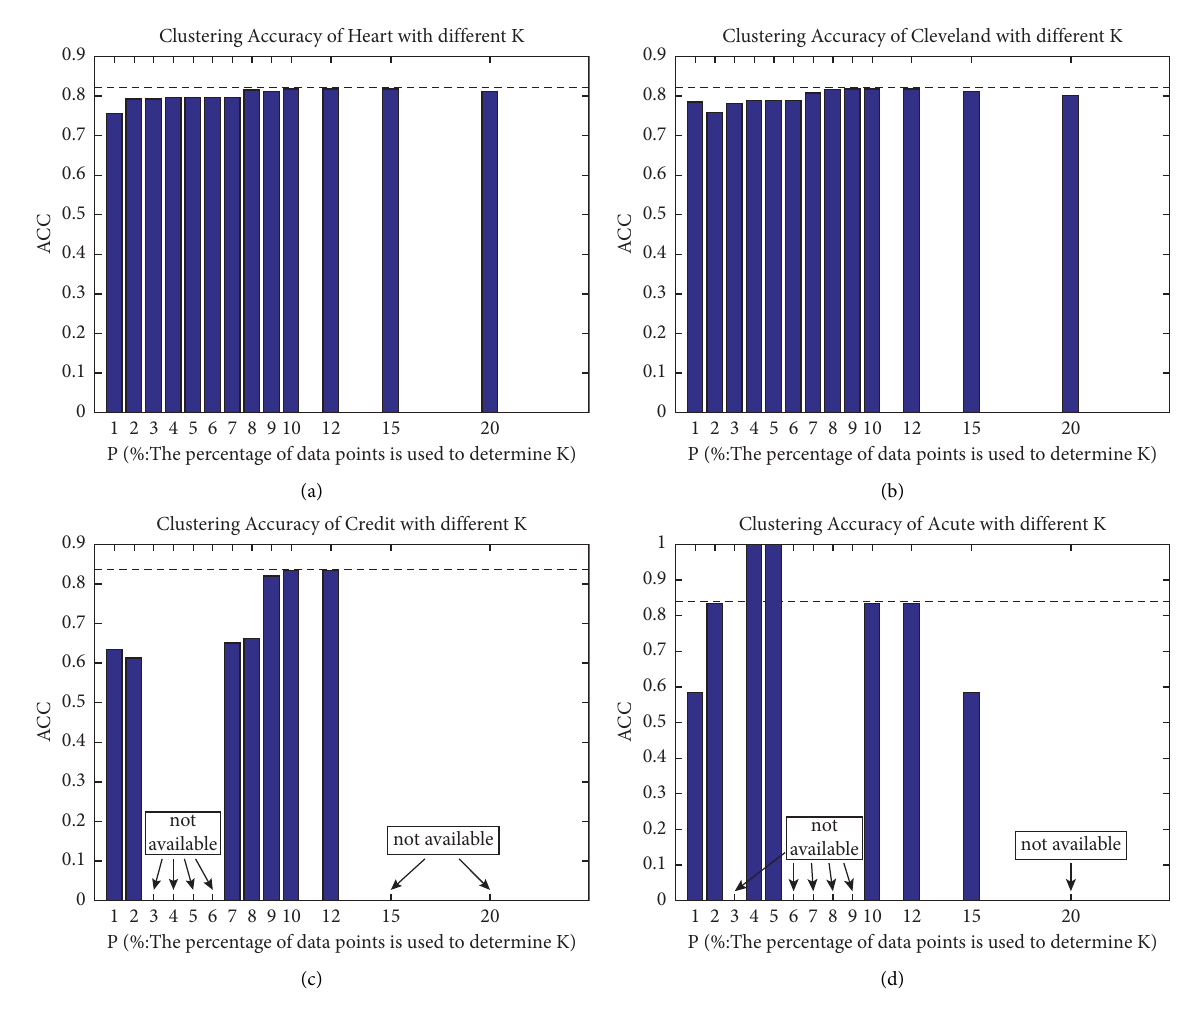
Figure 4: Clustering accuracy of datasets according to different K values. (a) Clustering accuracy of Heart with different K . (b) Clustering accuracy of Cleveland with different K . (c) Clustering accuracy of Credit with different K . (d) Clustering accuracy of Acute with different K